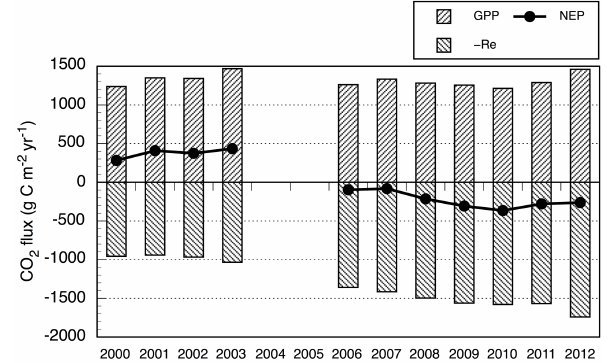
Figure 4. Interannual carbon flux changes in gross primary pro- duction (GPP), ecosystem respiration (Re), and net ecosystem pro- duction (NEP) before and after the disturbance. The values for the annual sums are missing in 2004 and